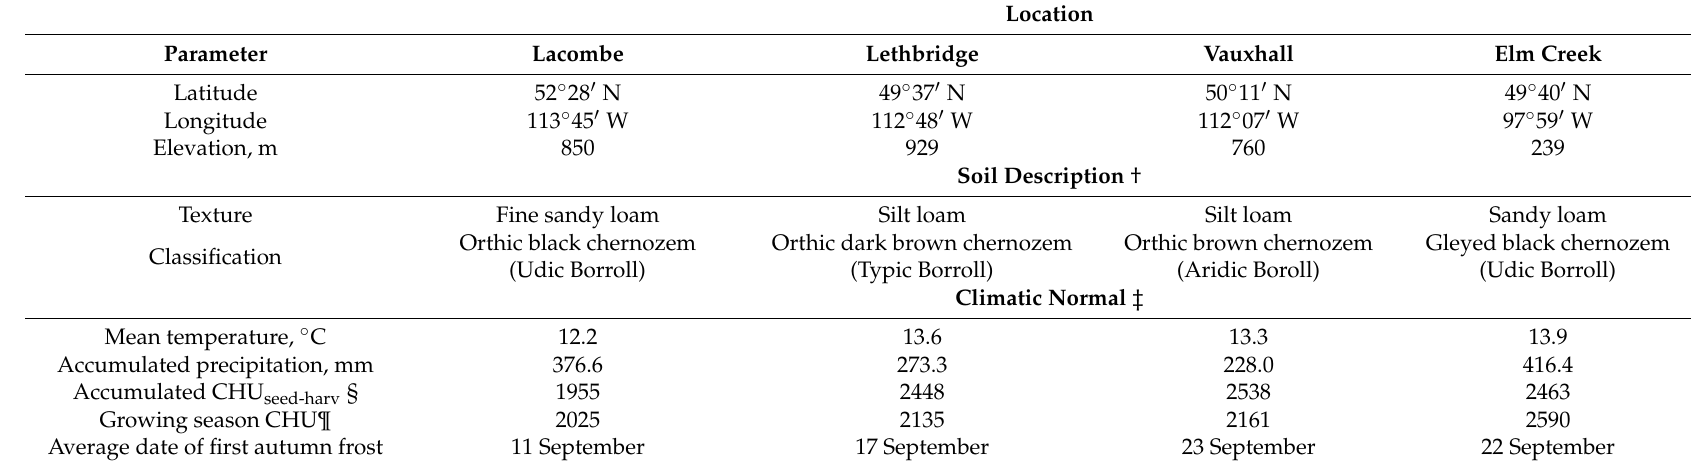
Table 1. Location, soil description and long-term climatic information for Lacombe, Lethbridge, and Vauxhall (Alberta) and Elm Creek